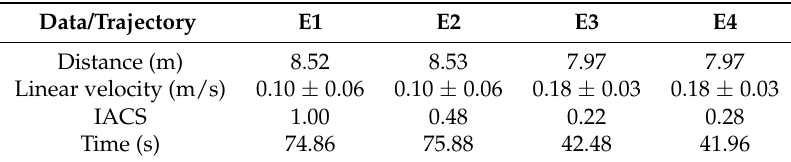
Table 3. Real world